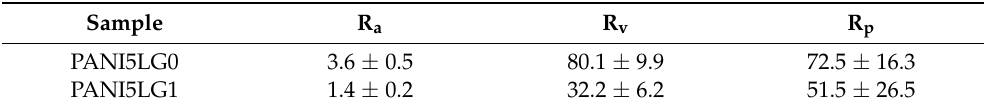
Figure 8. Digital pictures of printed films of ( A ) LG1PANI5 and (B) LG0PANI5 and representative confocal microscope images of ( C ) LG1PANI5 and ( D ) LG0PANI5. confocal microscope images of ( C ) LG1PANI5 and ( D ) LG0PANI5. Table 4. R a (roughness average), R v (average max roughness valley depth), and R p (average max roughness peak height) of the pTSA-PANI acrylic